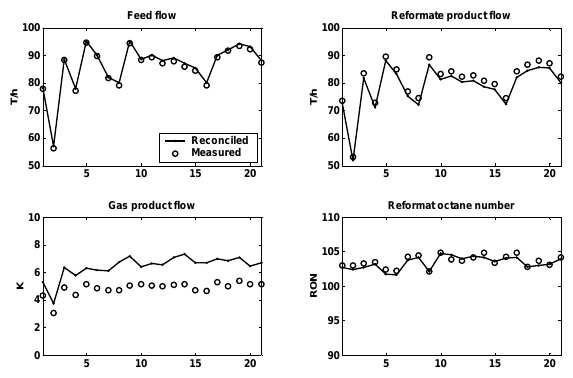
Figure 7: Reconciled mass flows and product quality for the 21 data sets